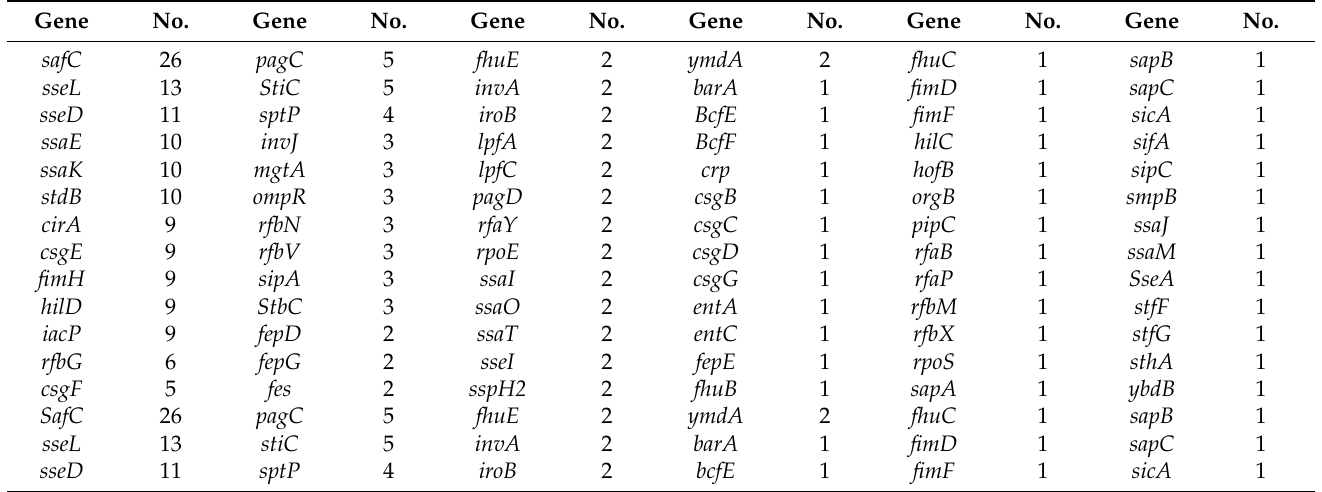
Table 3. Number of virulence gene variants present in each of 29 Salmonella enterica strains identified with the correct serovar designation as a result of automated, real time mapping of sequence reads to preloaded reference genomes by the Ion Torrent sequencer.